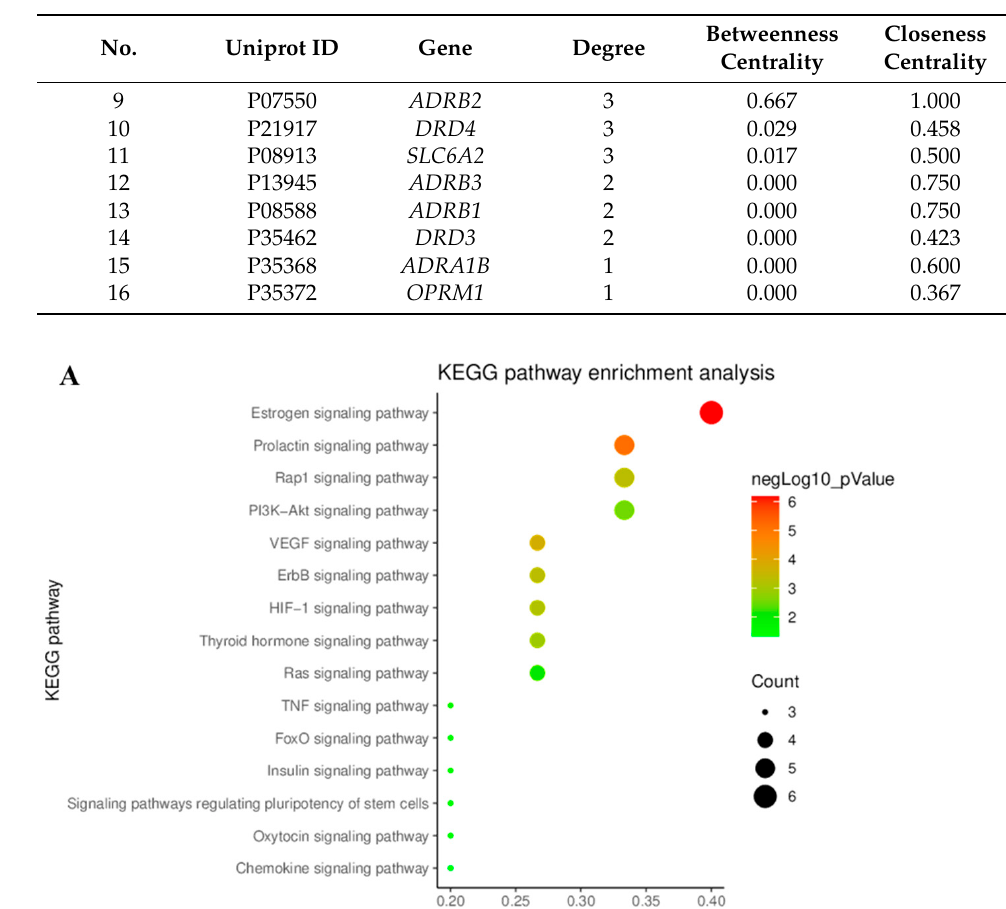
Figure 3. Protein–protein interaction network of potential anti-obesity target genes of p -synephrine. The size and red hue of a node represent its significance within the network.